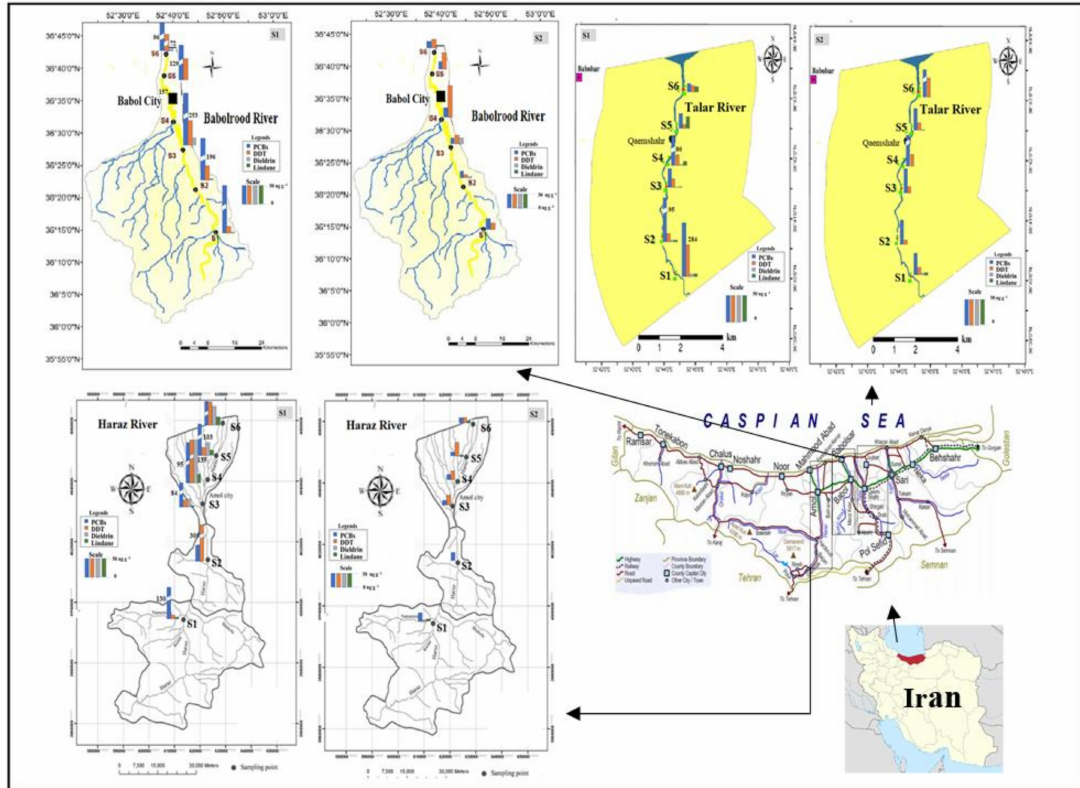
(cid:80) 7 PCBs, DDT,